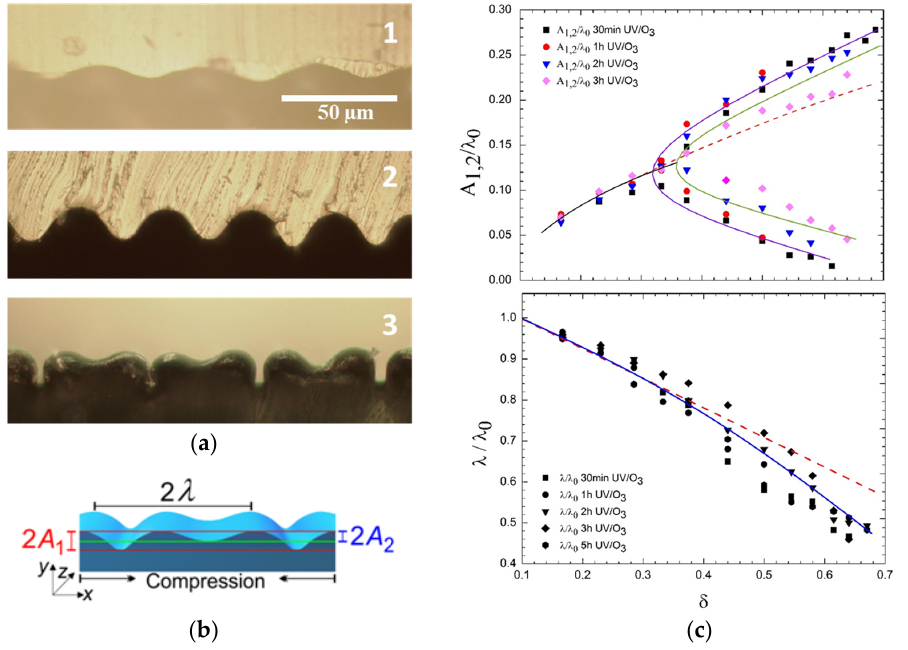
Figure 2. ( a ) Optical microscopy images of thin stiff PDMS film resting on a thick soft PDMS foundation, the PDMS foundation is cured with UV/ozone which modifies the elastic properties of its surface; ( b ) The system composed by the stiff film and the soft foundation is compressed uniaxially along the horizontal x ‐ axis. The wavelength and amplitudes of the wrinkles are measured for successive values of the relative compression δ ; ( c ) amplitudes, A 1 and A 2 , and wavelength, λ , as a function of the compression ratio δ .